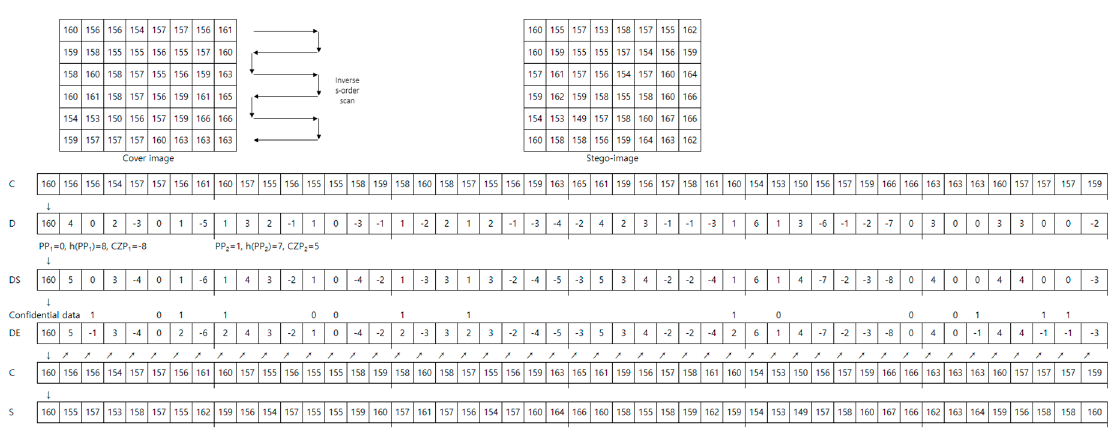
Figure 3. Data extraction and original cover image restoration procedure of APD.